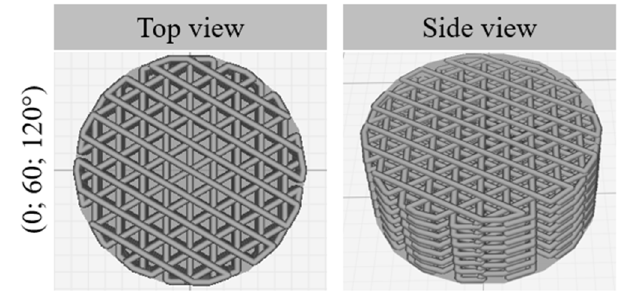
Figure 2 . Top and side views of the scaffolds (lay-down